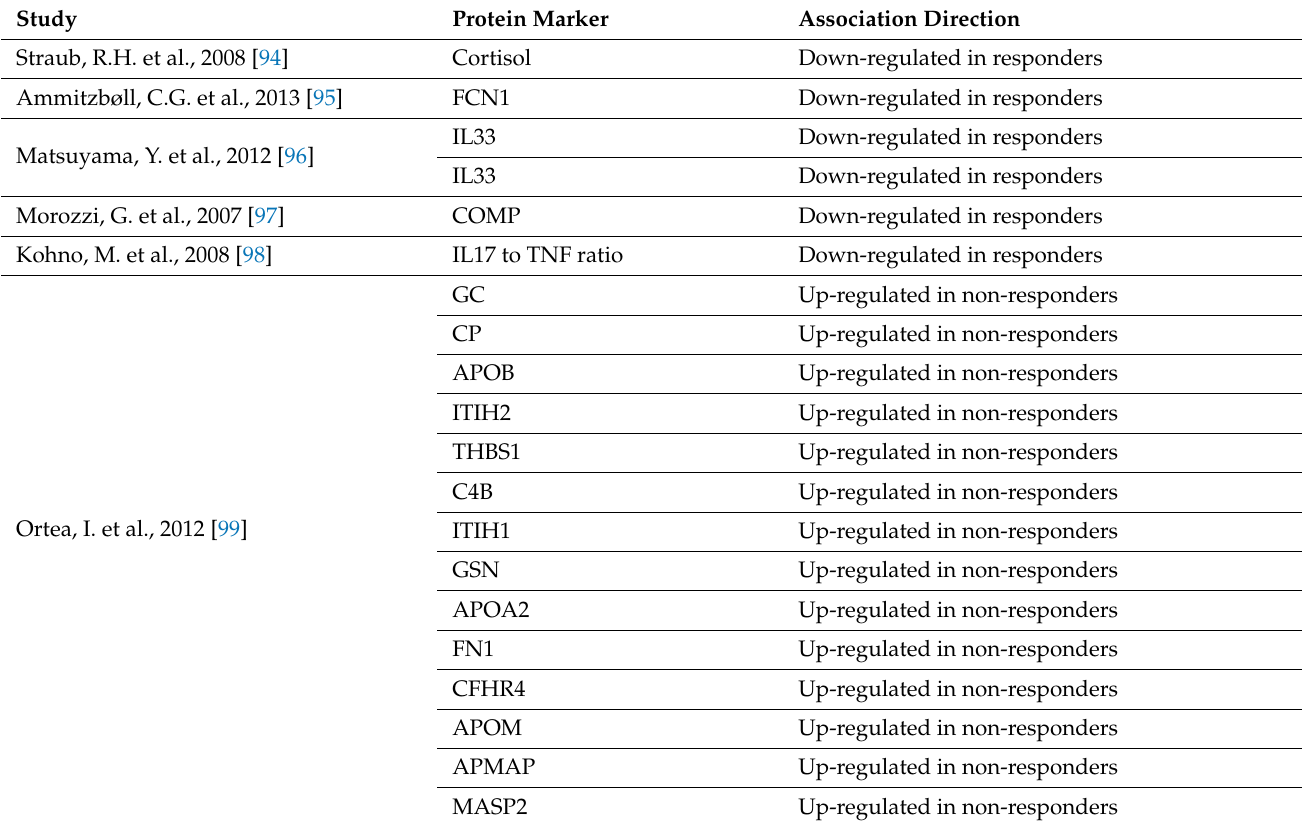
Table 4. Protein biomarkers of response to anti-TNF therapy in